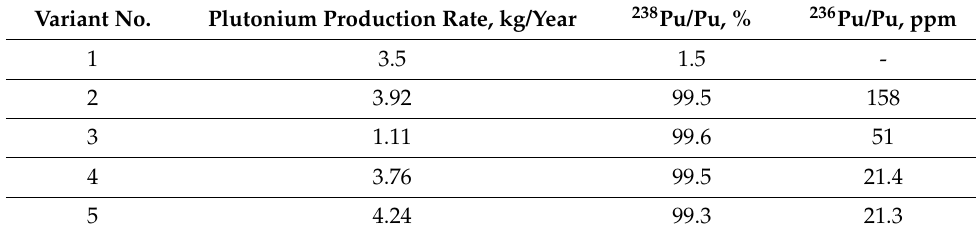
Table 2. Parameters of plutonium production in the irradiation device. Variant